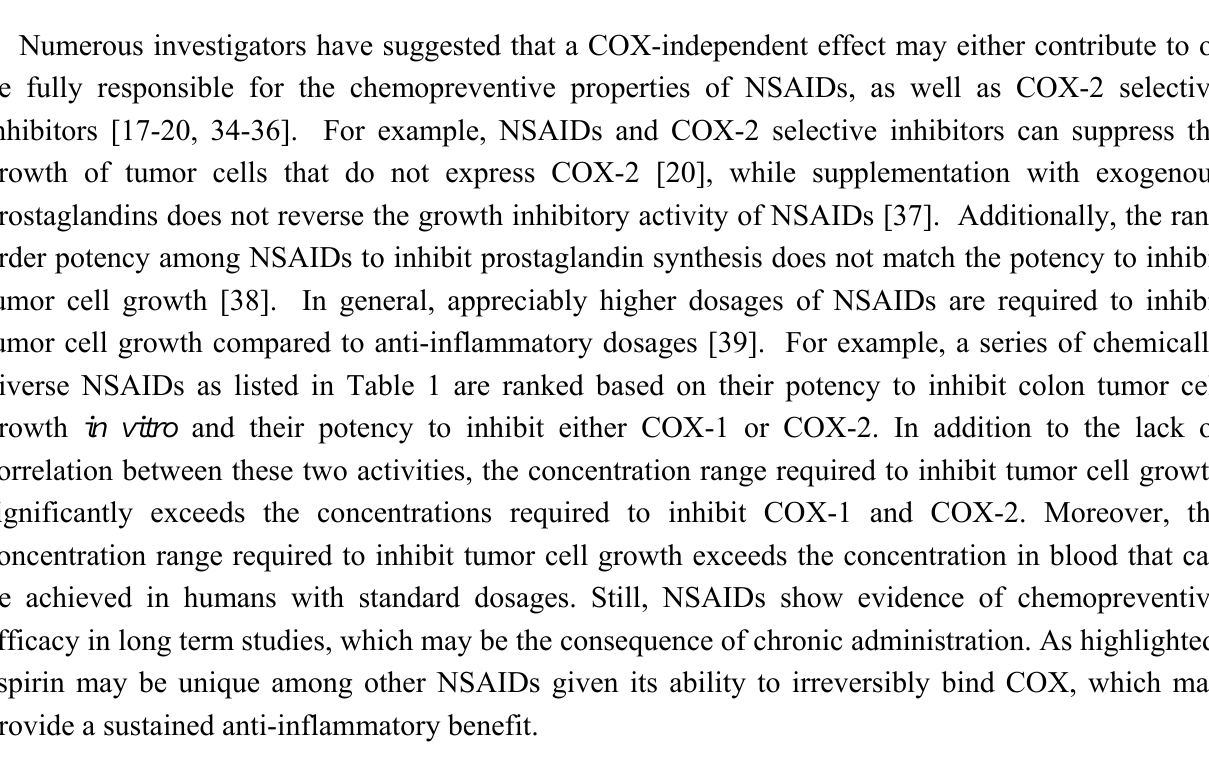
Table 1. Tumor cell growth and COX inhibitory activity of a panel of